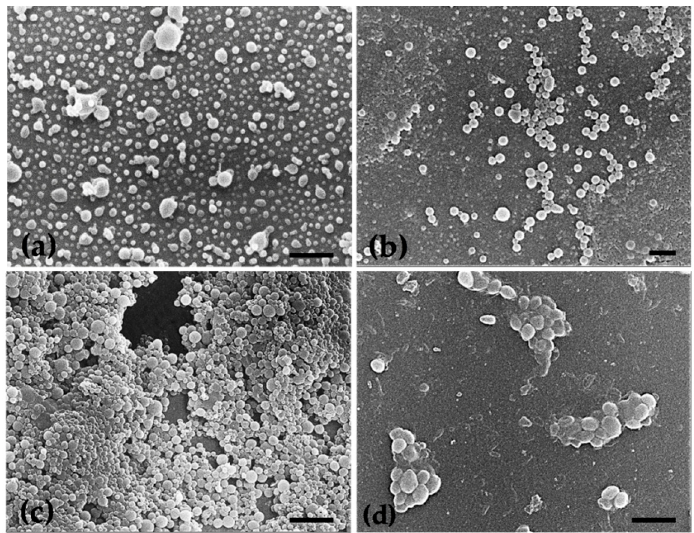
Figure 5. SEM micrographs showing the morphology of NPs. ( a ) Empty PLGA NPs, ( b ) Extract-loaded PLGA NPs, ( c ) Empty PCL NPs and ( d ) Extract-loaded PCL NPs. Scale bars = 2 μ m ( a, b ), 10 μ m ( c , d ).